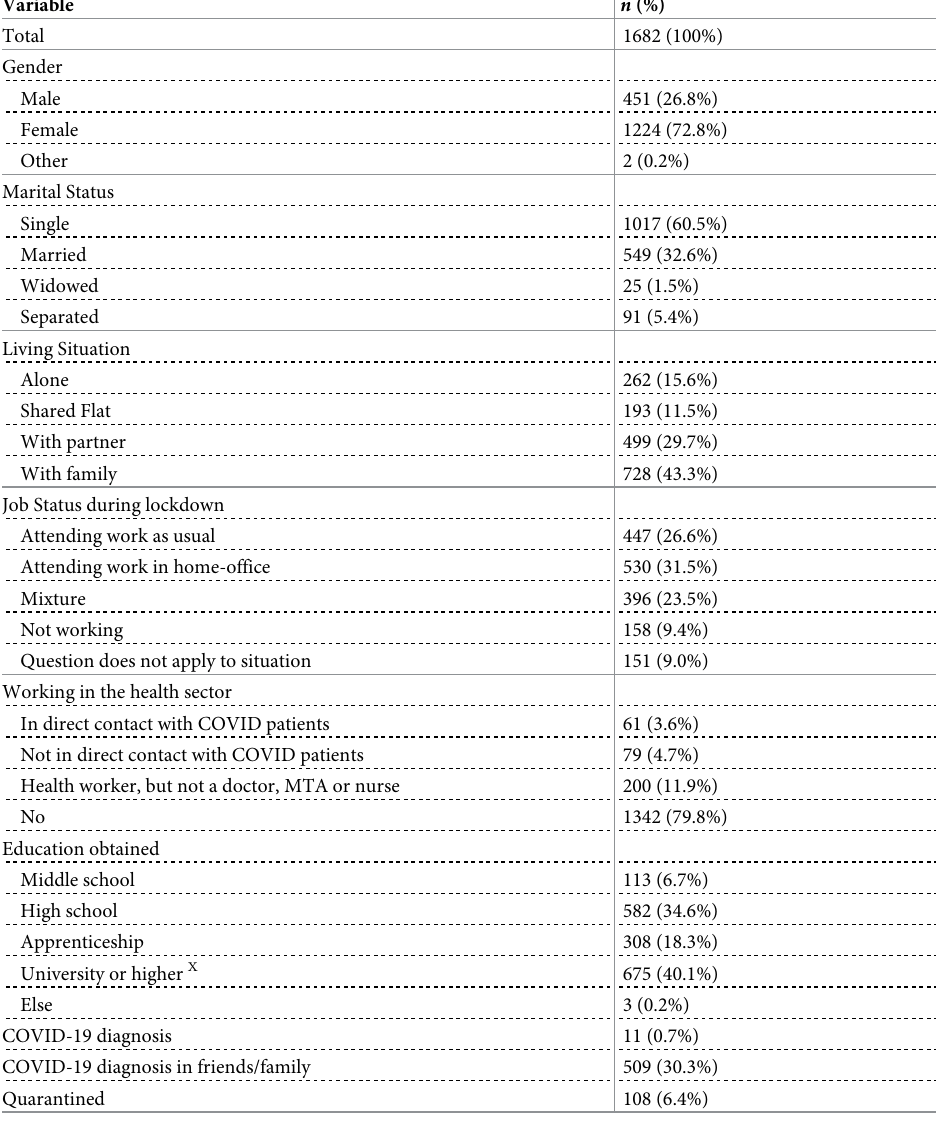
Table 1. Demographics of responders (N =